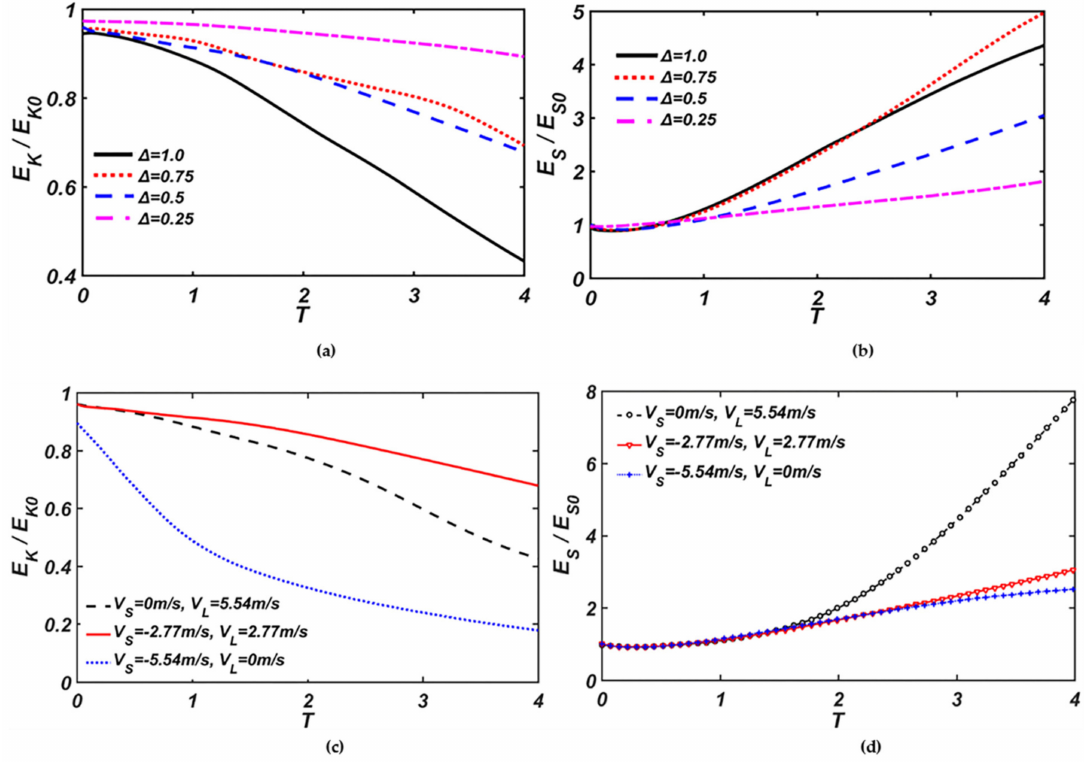
Figure 9. Evolution of dimensionless kinetic energy and surface energy of the droplets, the size